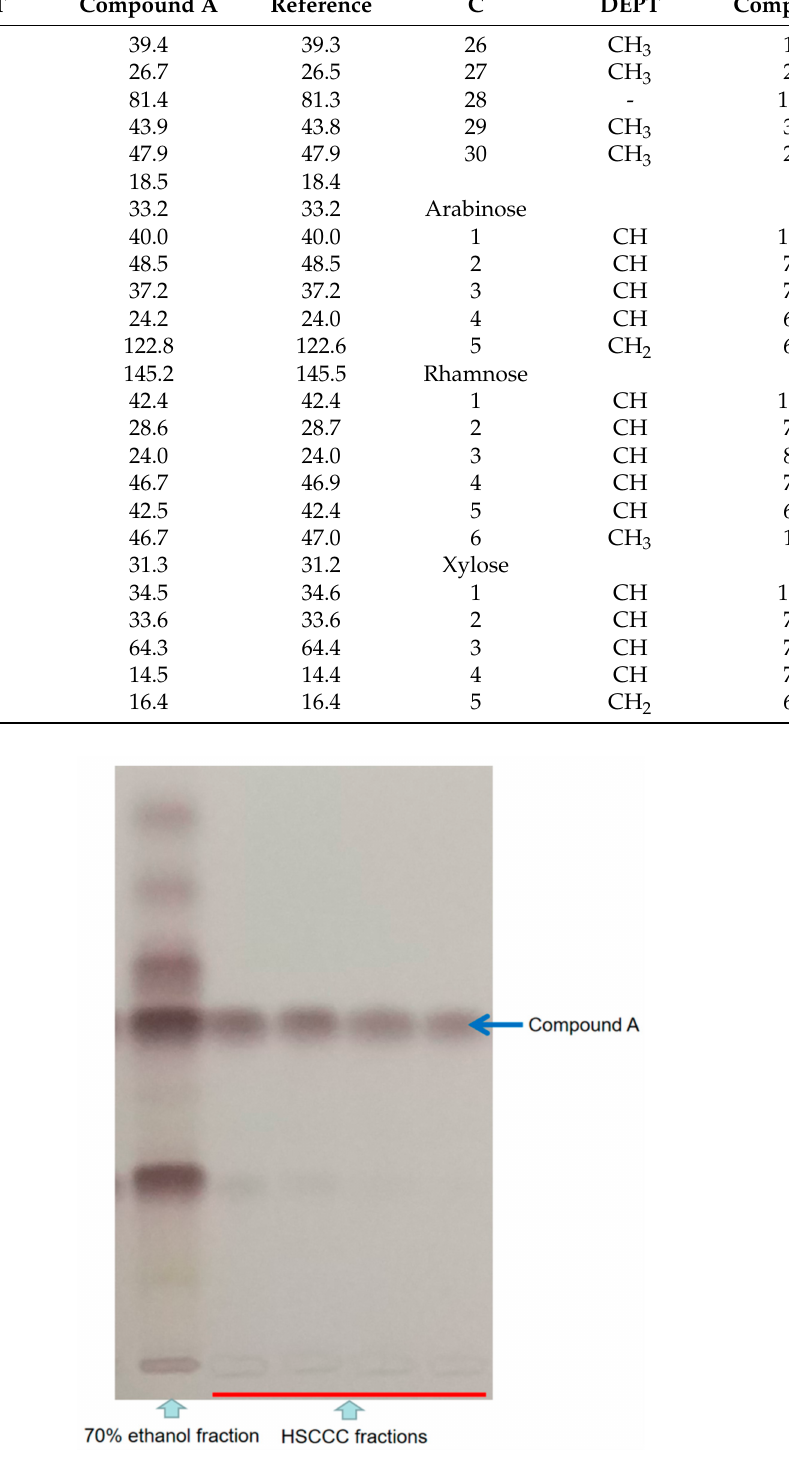
Figure 3. Thin layer chromatography (TLC) photograph of different high-speed counter-current chromatography (HSCCC) fractions and 70% ethanol fraction at white light after